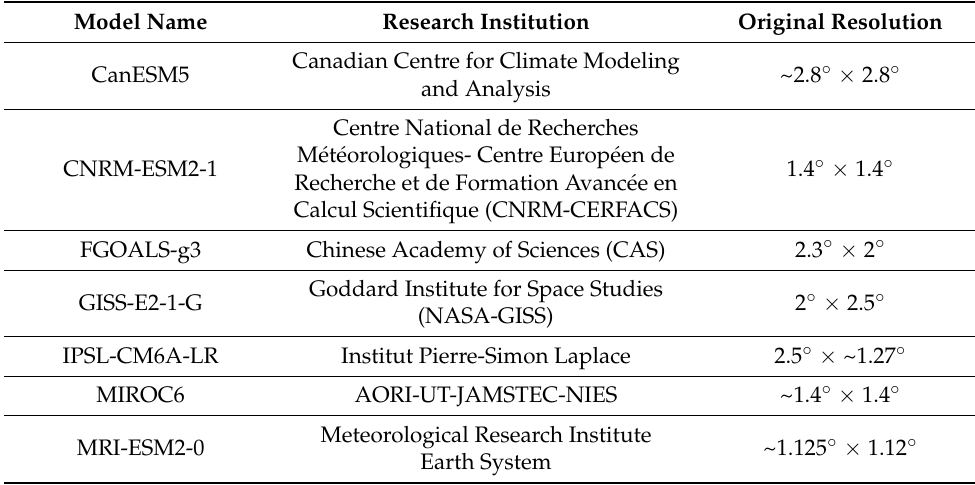
Table 1. Basic information on the seven GCMs used in this